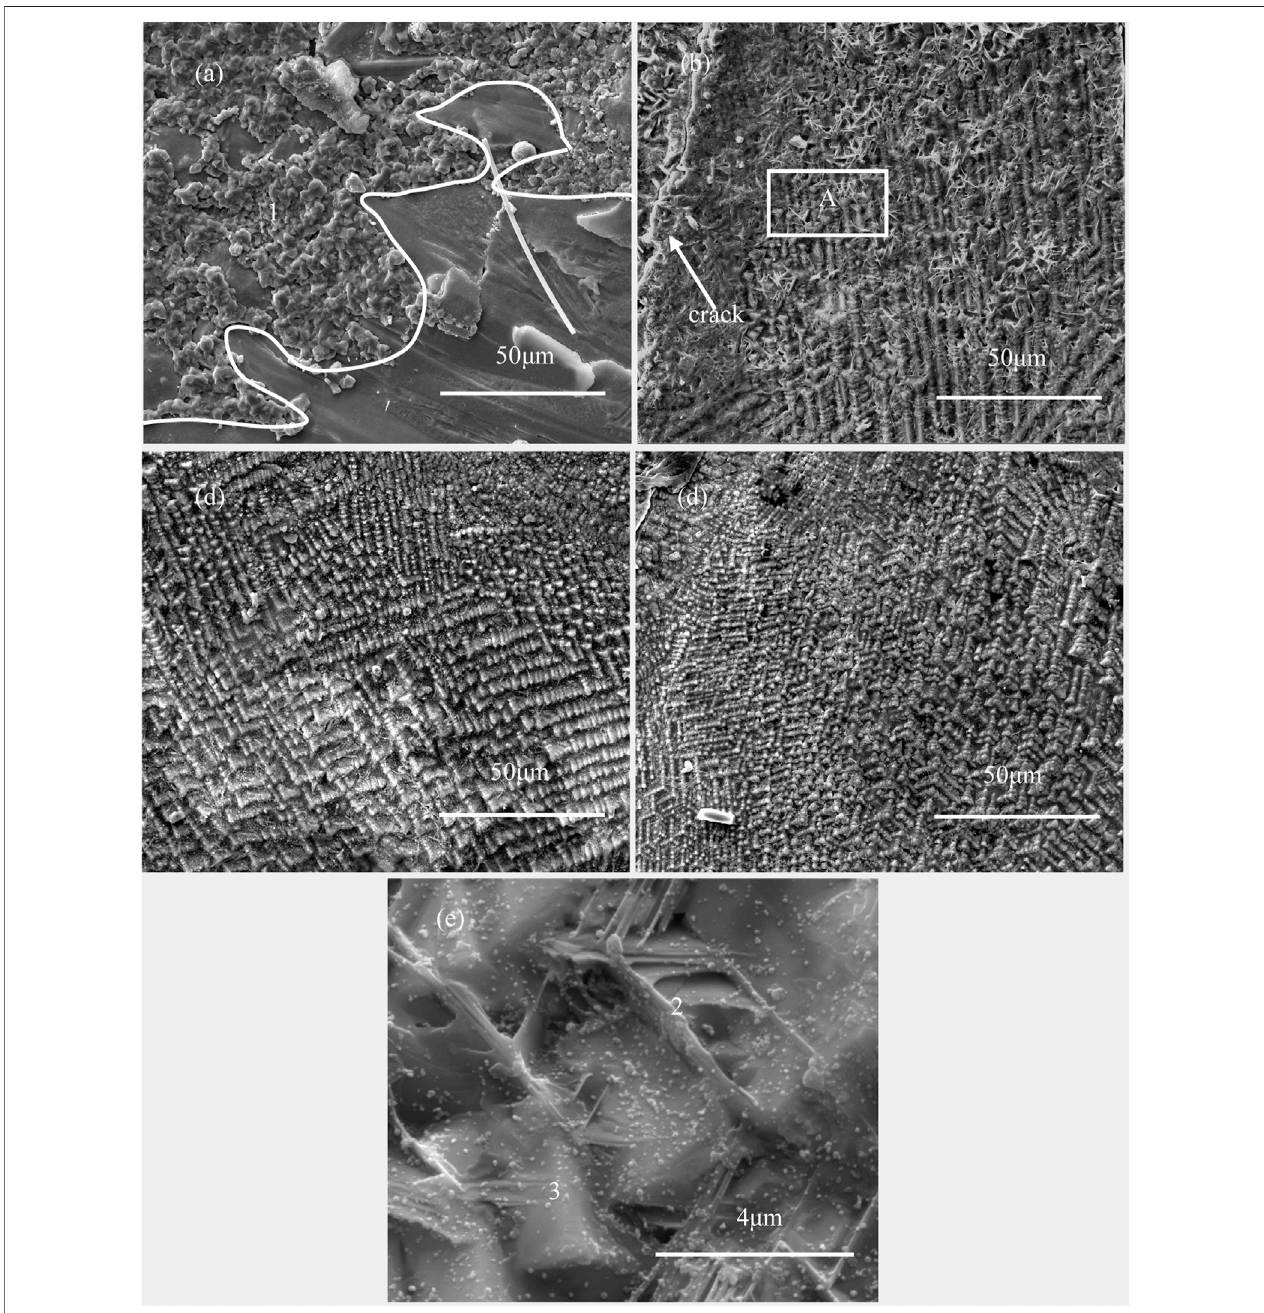
FIGURE7| Surfacemorphologiesofthecoatingscontaining (A) 0wt%Sm 2 O 3 ; (B) 1wt%Sm 2 O 3 ; (C) 3wt%Sm 2 O 3 ; (D) 5wt%Sm 2 O 3 . (E) Themagni fi ed fi gureof zone A after oxidation at 900 ° C for 100 h.